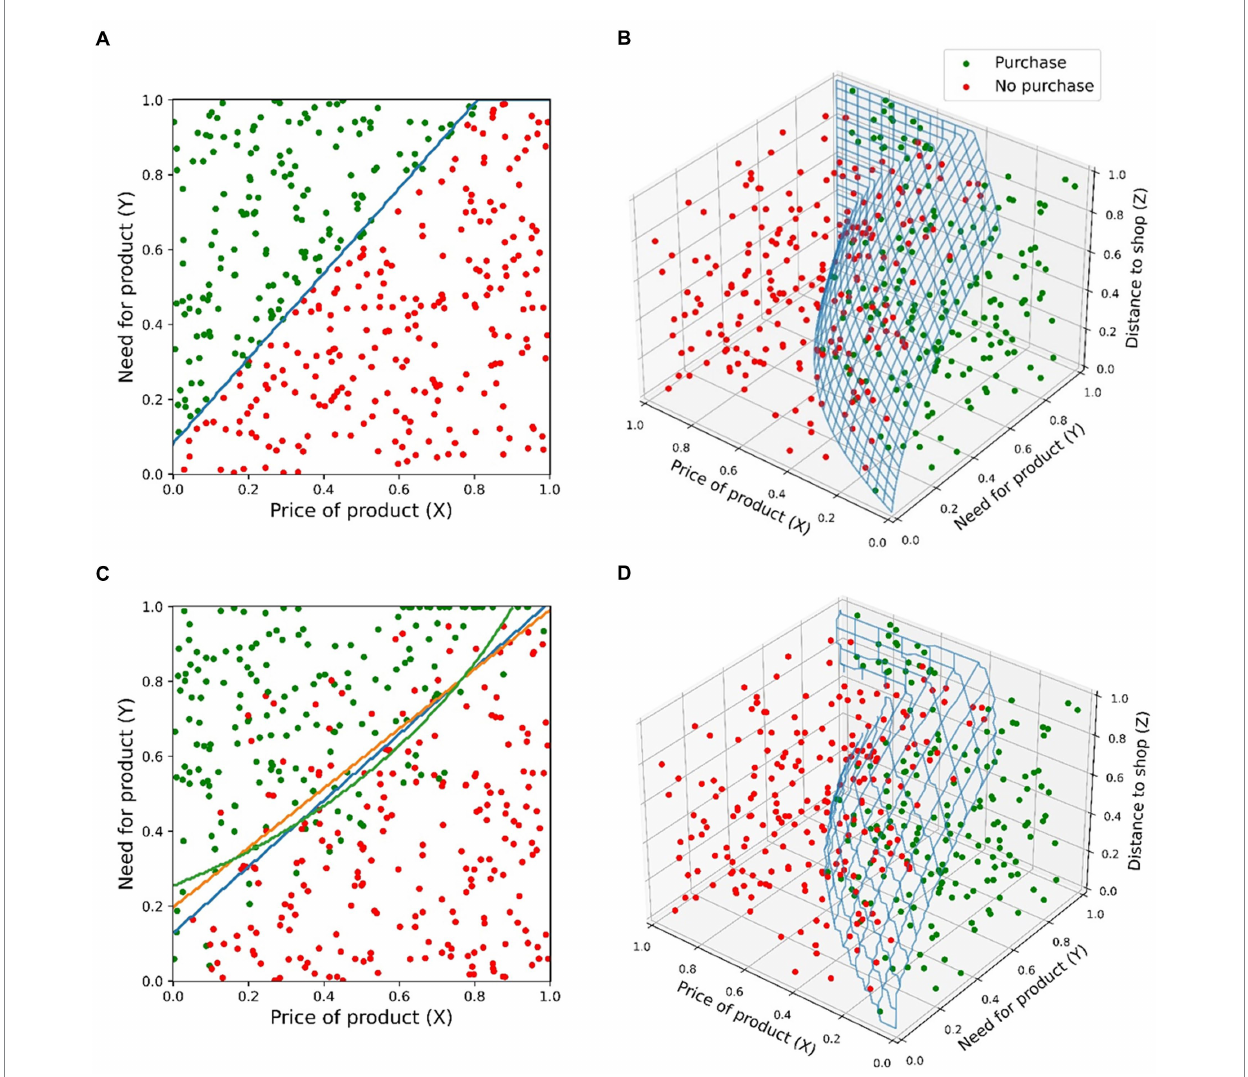
FIGURE 1 Hypothetical illustration of a decision to buy a certain product surveyed from 400 respondents. (A) Survey results in a laboratory setting depend on only two parameters: Price (X) and need (Y) for the product. Decision boundary fitted using a linear logistic regression model with red and green points corresponding to negative and positive decisions to buy. (B) A repeat of the experiment outside the laboratory with a third variable (Z) as a customer distance to the shop. The decision boundary is a complex, non-linear function. (C) Three models fitted to data with only two parameters included; models are linear (orange), quadratic (green), and neural network (blue). (D) Neural network model fitted to the full data with all three